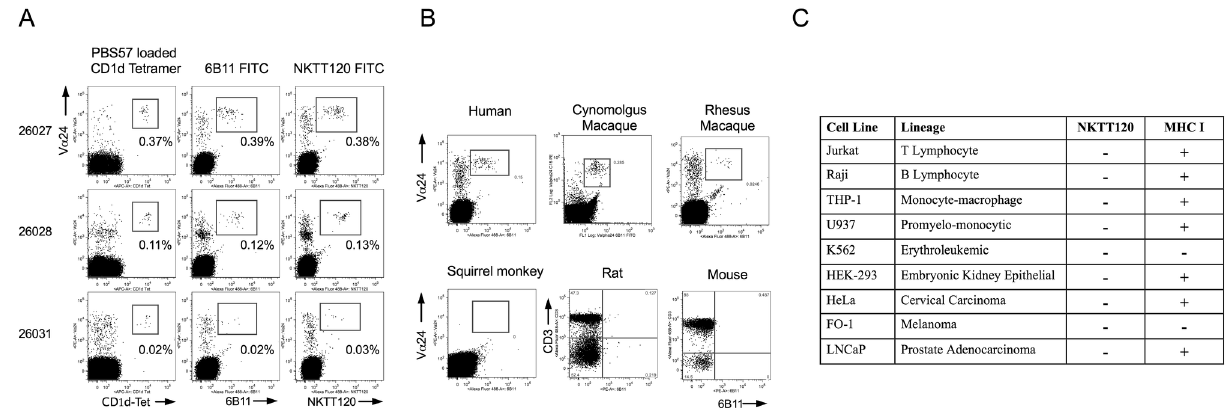
Figure 1. Whole blood samples from healthy volunteers were stained with antibodies against CD3 (Clone SP34.2), TCR Vα24 (Clone C15) and either PBS57 loaded CD1d Tetramer, 6B11 or NKTT120. Red blood cells were subsequently lysed, cells washed and analyzed by flow cytometry. The data shown is gated on CD3+ cells ( A ). Human, Cynomolgus Macaque, Rhesus Macaque, Squirrel Monkey whole blood samples and rat and mouse splenocytes were stained with antibodies against CD3 (Primates: Clone SP34.2, Rat: Clone 1F4, mouse: Cone 17A2), TCR Vα24 (Clone C15) and invariant TCR (6B11). Red blood cells were subsequently lysed, cells washed and analyzed by flow cytometry (B). Human cell lines (106 per sample) were incubated with NKTT120 or isotype control, washed and stained with anti Human IgG (Clone G18-145) and pan MHC-I (Clone G46-2.6), washed and analyzed by flow cytometry